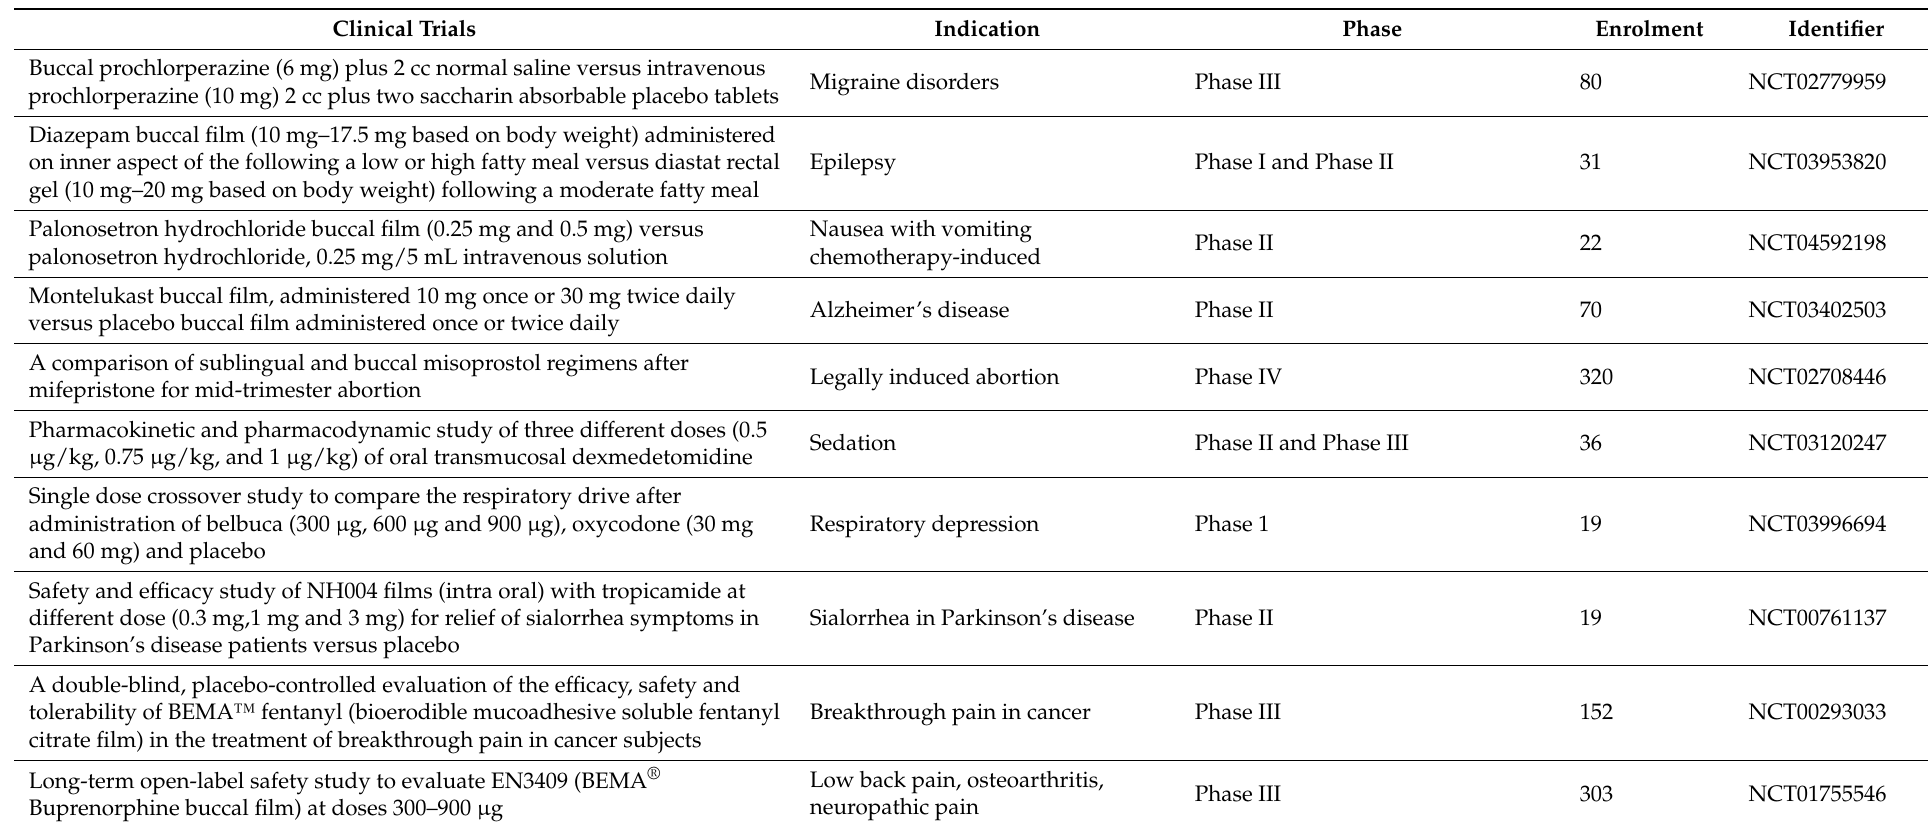
Table 6. Ongoing and completed clinical trials of buccal film formulations designed for systemic